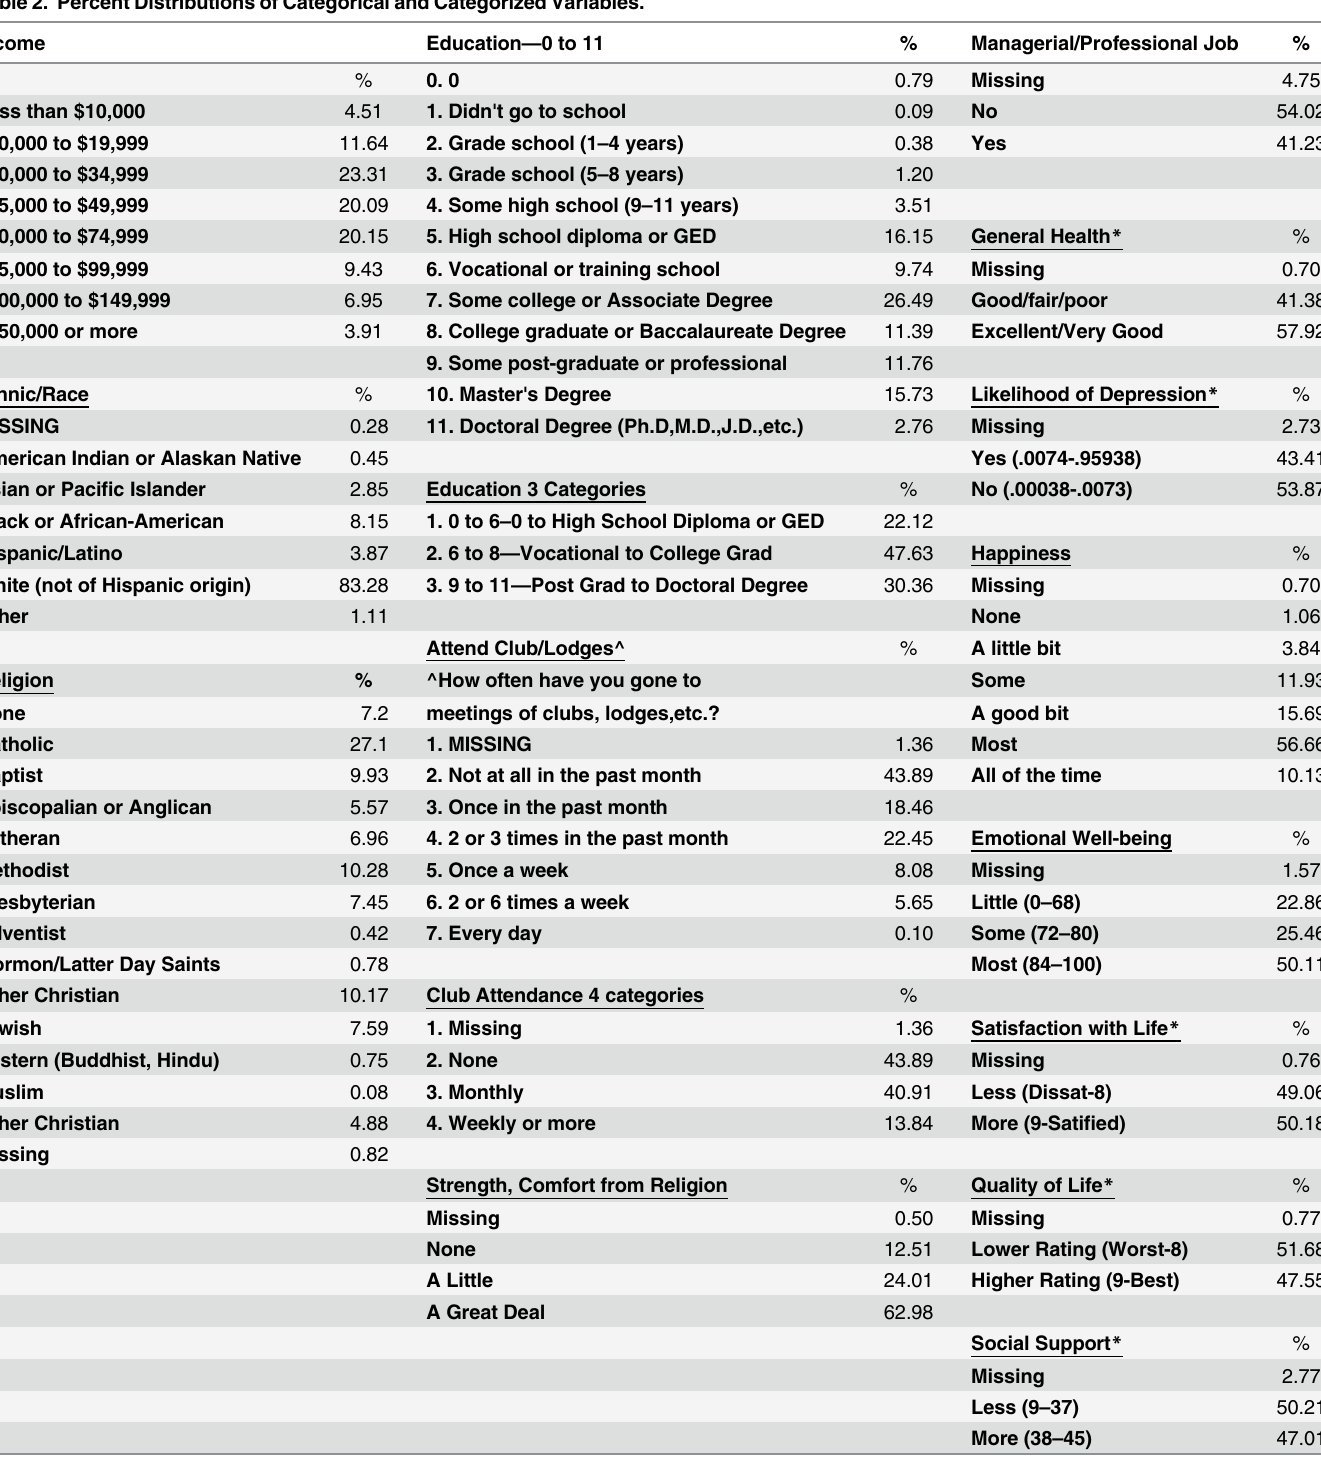
Table 2. Percent Distributions of Categorical and Categorized